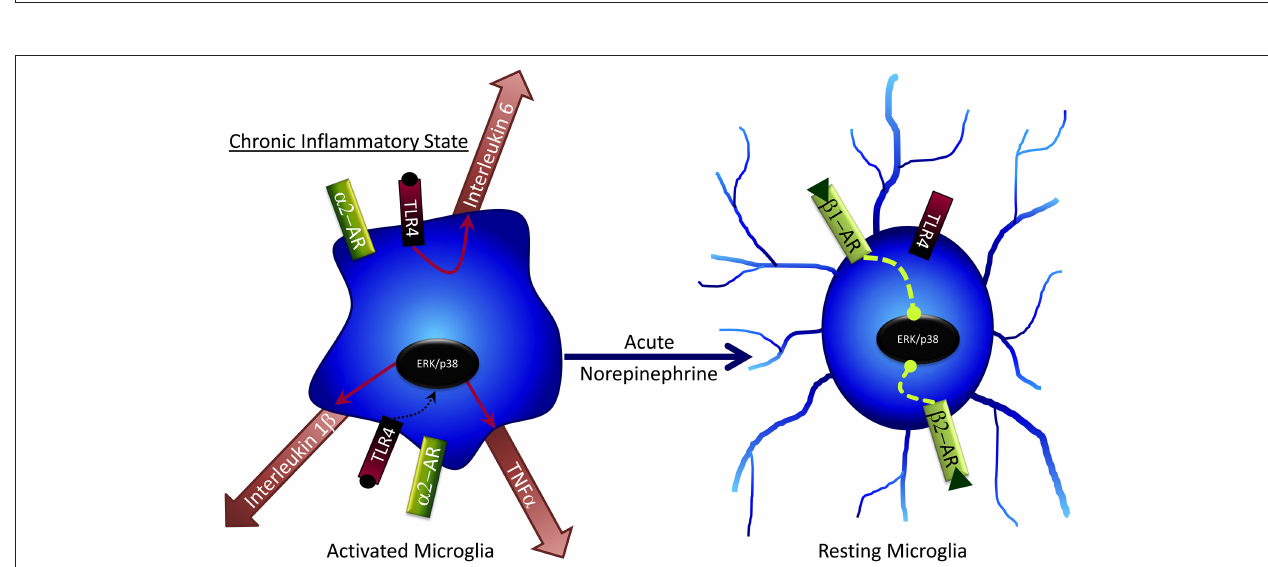
FIGURE 4 | Acute norepinephrine exposure can decrease release of cytokines by microglia via inhibition of ERK/p38 signaling.